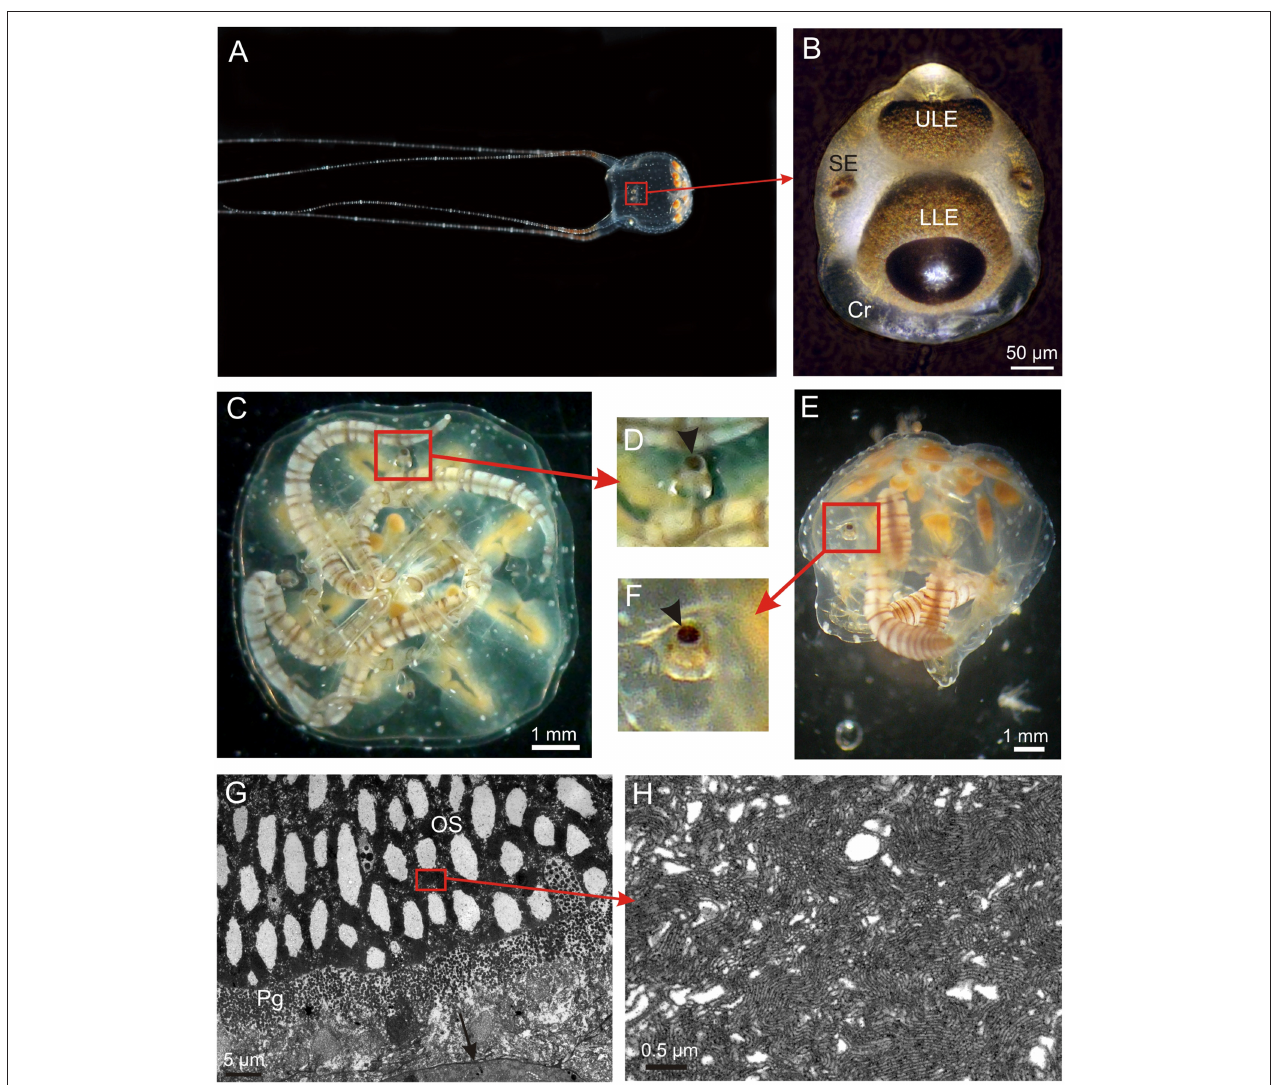
FIGURE 1 | The visual system of Copula sivickisi . (A) An adult male fishing with outstretched tentacles. Framed area indicates location of one of the rhopalia. (B) Close up of a rhopalium showing four of the six eyes. Note the large crystal (Cr) distally. (C) Resting medusae lying upside down but the rhopalia still orient with the upper lens eye pointing straight upwards due to the heavy crystal. (D) Close up of framed area in (C) showing upright rhopalium, arrowhead indicates upper lens eye. (E) Medusa laying on the side still having upright rhopalia. (F) Close up of framed area in (E) showing upright rhopalium, arrowhead indicates upper lens eye. (G) TEM micrograph of photoreceptors in the lower lens eye. The outer segments (OS) are modified cilia, and the photoreceptors also contain screening pigment (Pg). Note apparent holes in the outer segments. (H) Close up of OS showing the cilia projecting densely packed microvilli. LLE, lower lens eye; SE, slit eye; ULE, upper lens